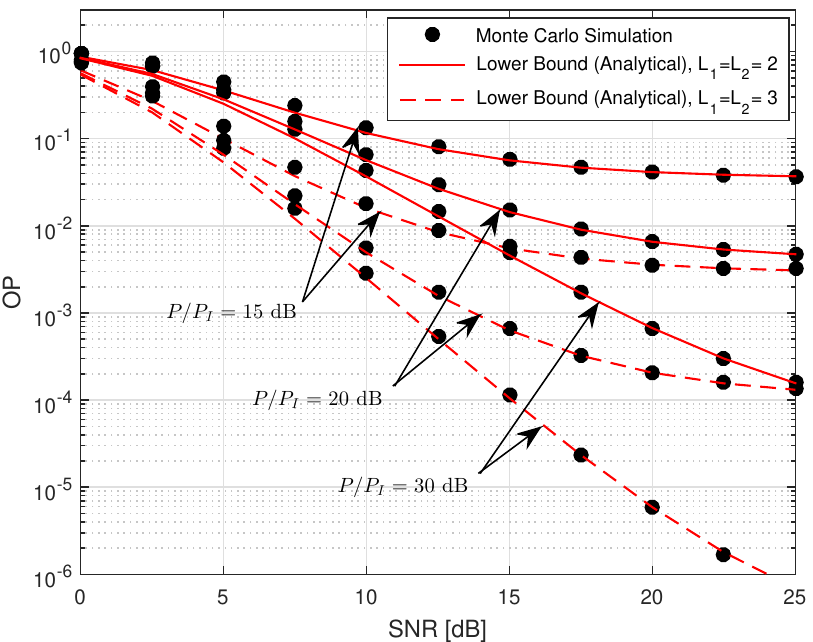
Figure 2. System outage probability considering different SIR values, γ th = 0 dB and N = 6.